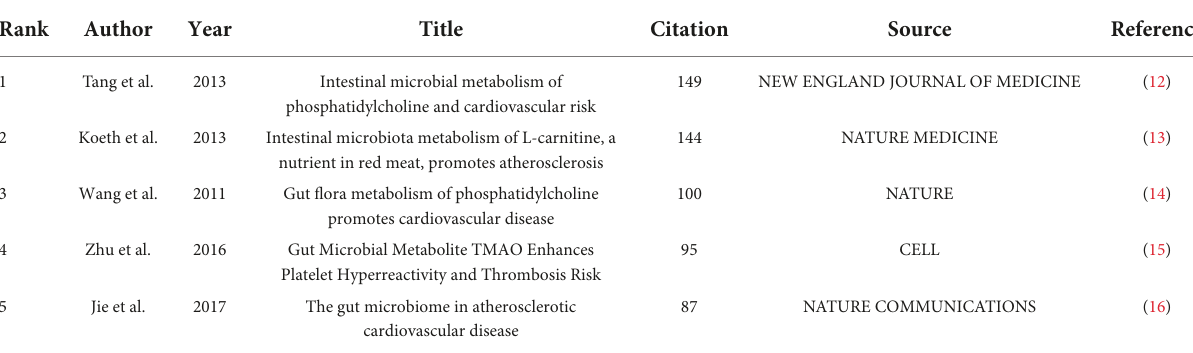
TABLE 3 Top 5 co-cited references on CHD and gut